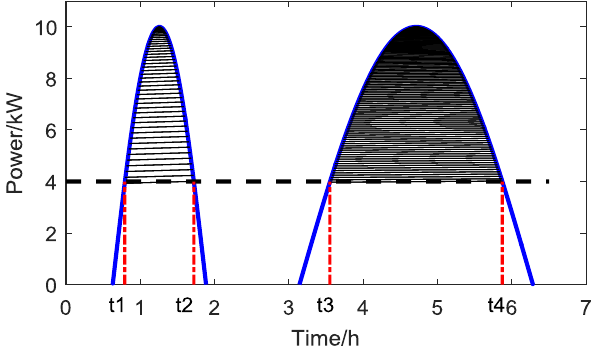
Figure 4. The definition of the continuous power-energy (CPE).